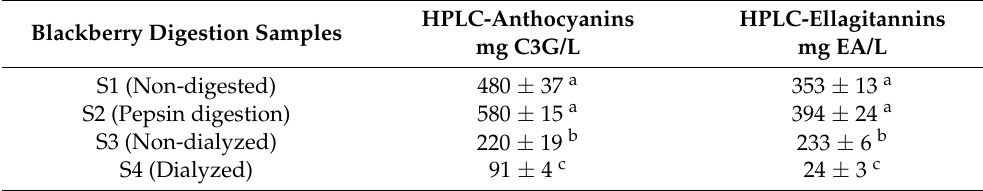
Table 1. Anthocyanins and ellagitannins concentrations in the blackberry juice digestion